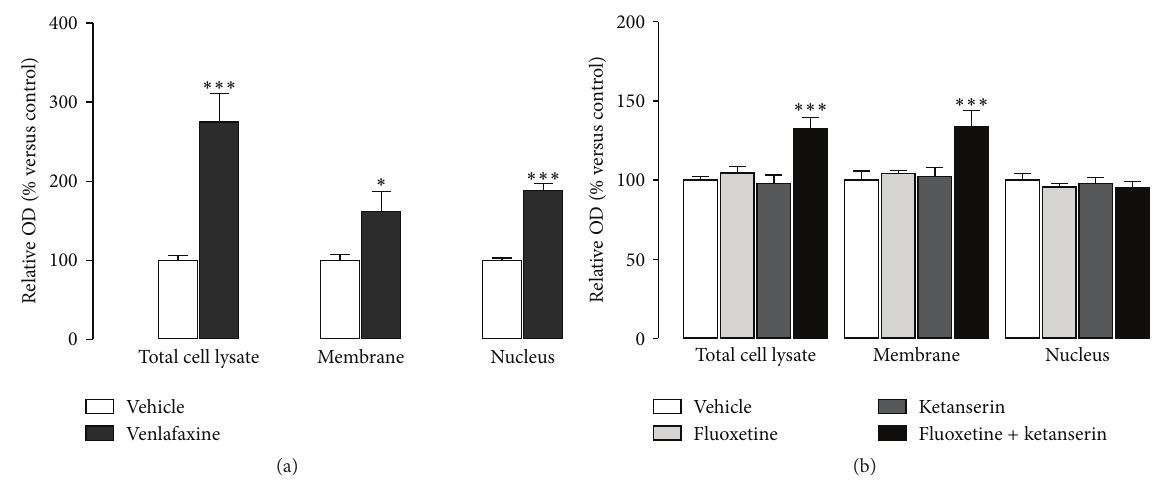
Figure 5: Implication on 𝛽 -catenin subcellular distribution of the chronic (14 days) antidepressant treatment with the SNRI venlafaxine antagonist ketanserin (0.1mg/kg/day), and the (40mg/kg/day) (a), and 7-day treatment with the SSRI fluoxetine (5 mg/kg/day), the 5 -HT 2 A combination of both (b). Note that chronic treatment with venlafaxine produces an increase in both membrane-associated and nuclear 𝛽 - catenin,whilethesubchronictreatmentwithfluoxetine+ketanserin,onlyincreases 𝛽 -catenininthemembranebutnotinthenuclearfraction. ∗ 𝑃 < 0.05 and ∗∗∗ 𝑃 < 0.001 versus vehicle. (a) Modified from Mostany et al., 2008 [10], and (b) modified from Pilar-Cuellar et al., 2012